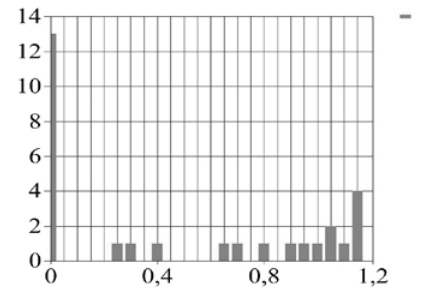
Fig. 3. The fragment of a fractal dimension histogram corresponding to the centers of a forest